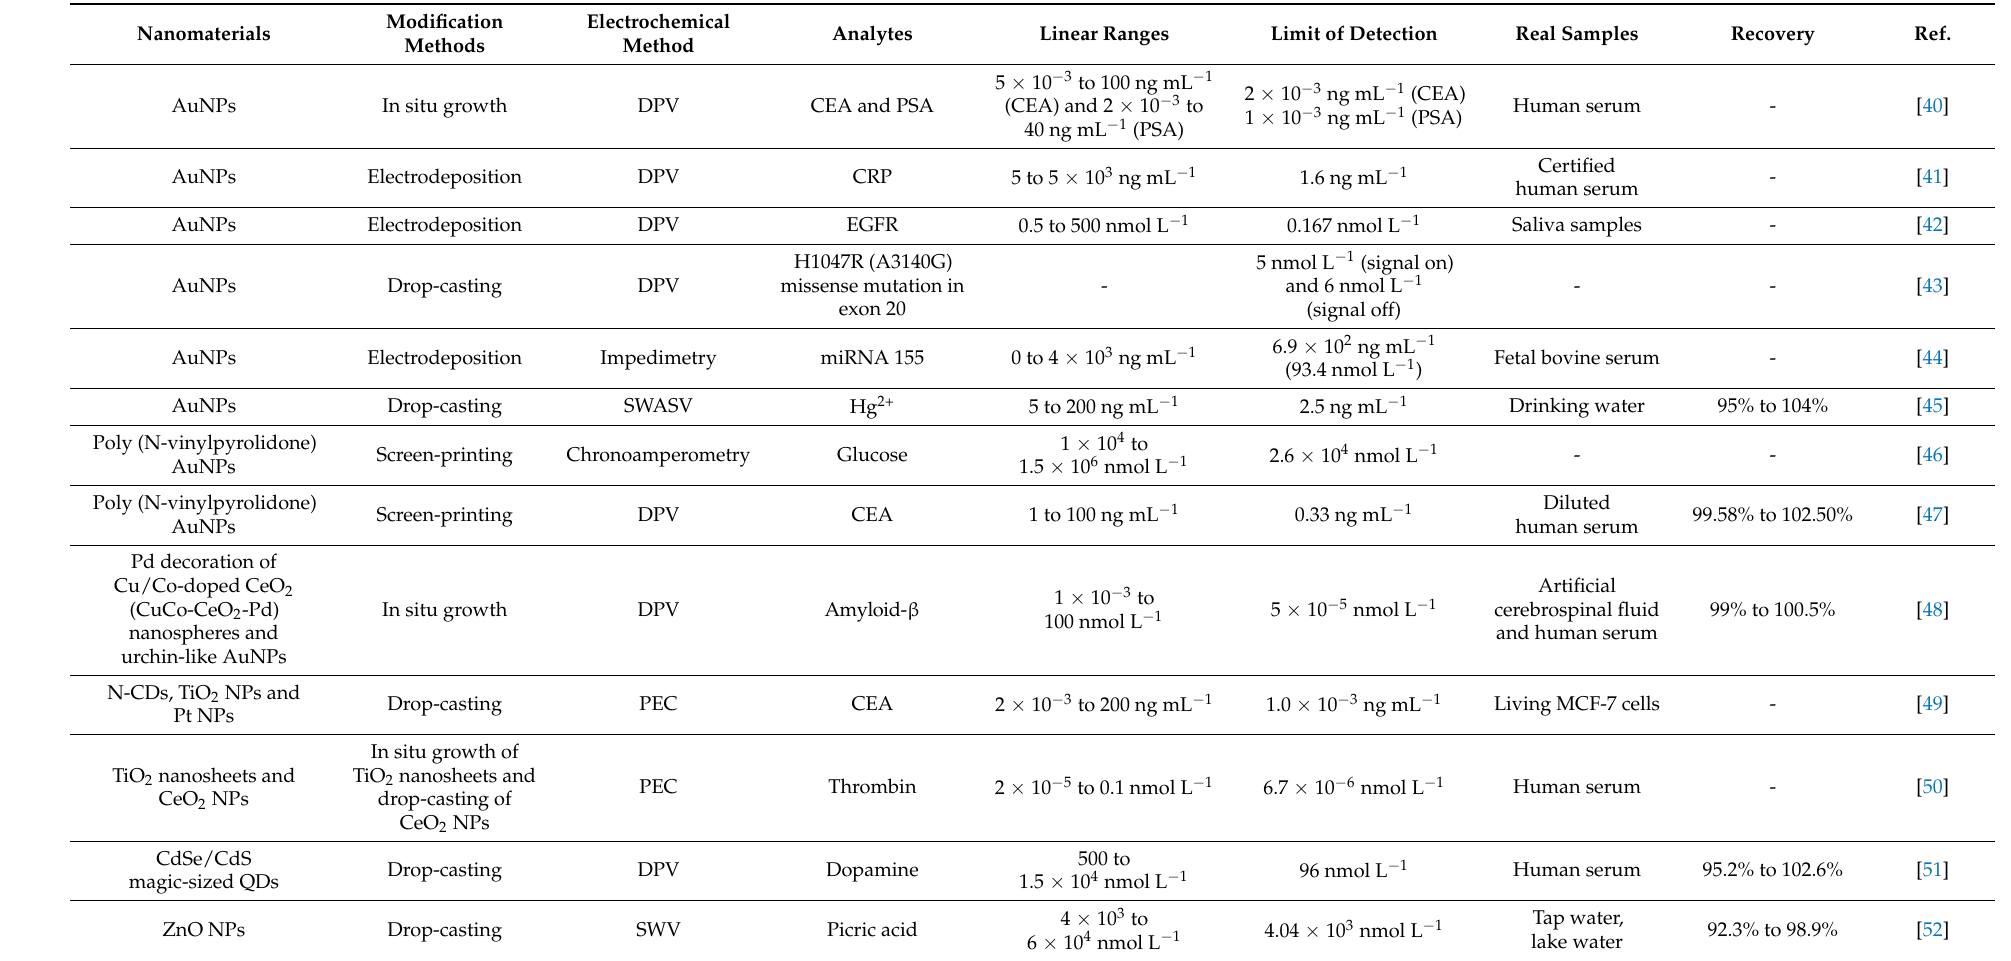
Table 1. The typical nanomaterial-enhanced ePADs for sensing various